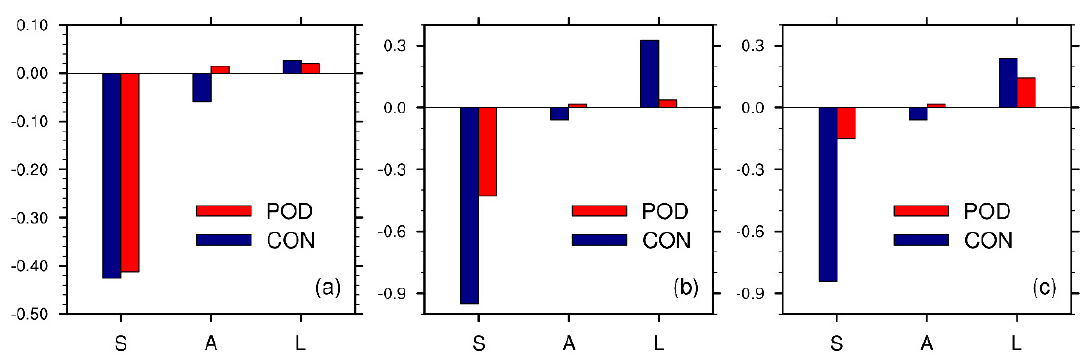
Figure 10. The SAL scores of 24-h accumulated precipitation from 0000 UTC 30 June to 0000 UTC 01 July 2017 at thresholds of ( a ) >0 mm, ( b ) >50 mm, and ( c ) >100 mm.